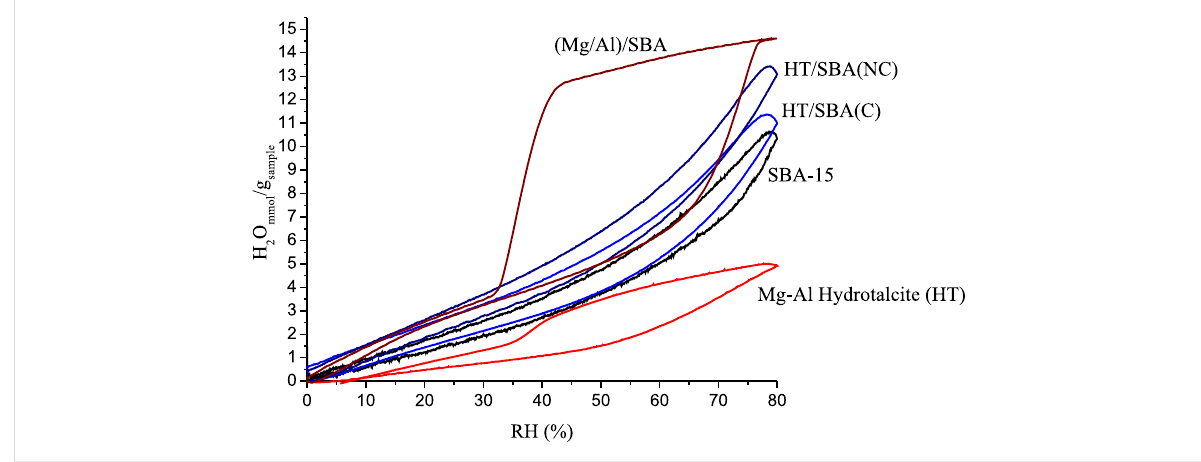
Figure 5: Adsorption–desorption isotherms of water vapor of the HT, SBA-15 and nanoporous composites.